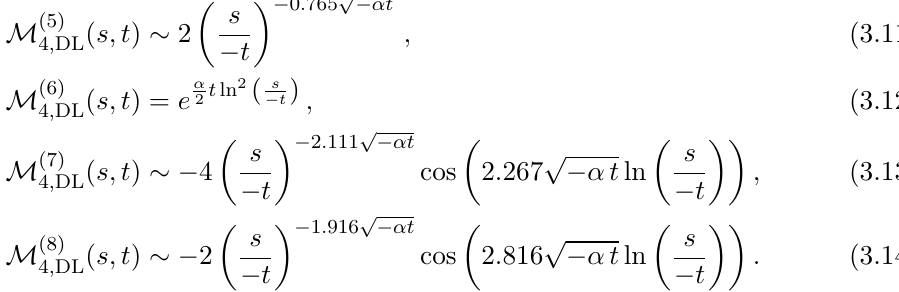
(cid:16) (cid:17) z p with the largest real part. 2 as shown in 4